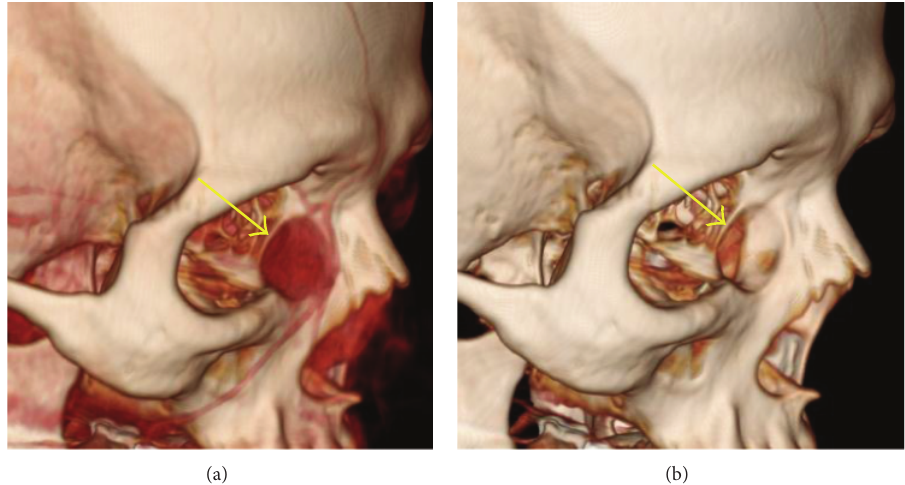
Figure 4: Involvement of adjacent bony structures by tumor demonstrated by 3D imaging. A 53-year-old woman with lacrimal sac inverted papilloma. (a) 3D image, soft tissue window: tumor in the left lacrimal sac (arrow). (b) 3D image, bone tissue window. The tumor has been removed to show underlying bone remodeling